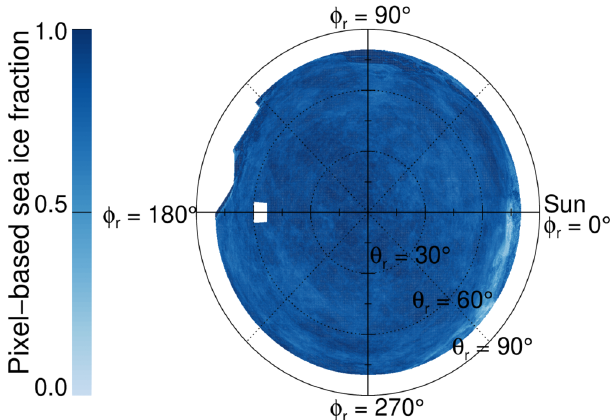
Figure 12. Sea ice fraction observed at each pixel throughout the images used for the test data set (pixel-based sea ice